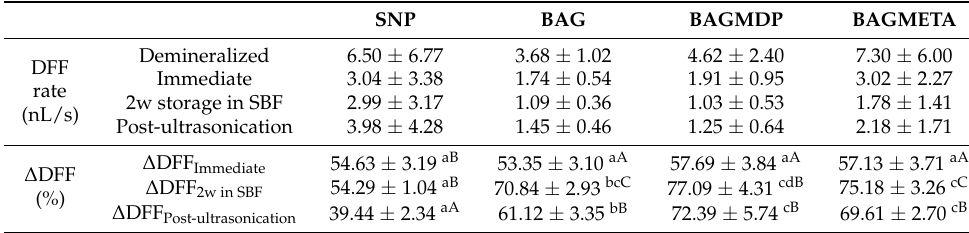
Table 2. Real-time changes in DFF rate and ∆ DFF (n = 5).